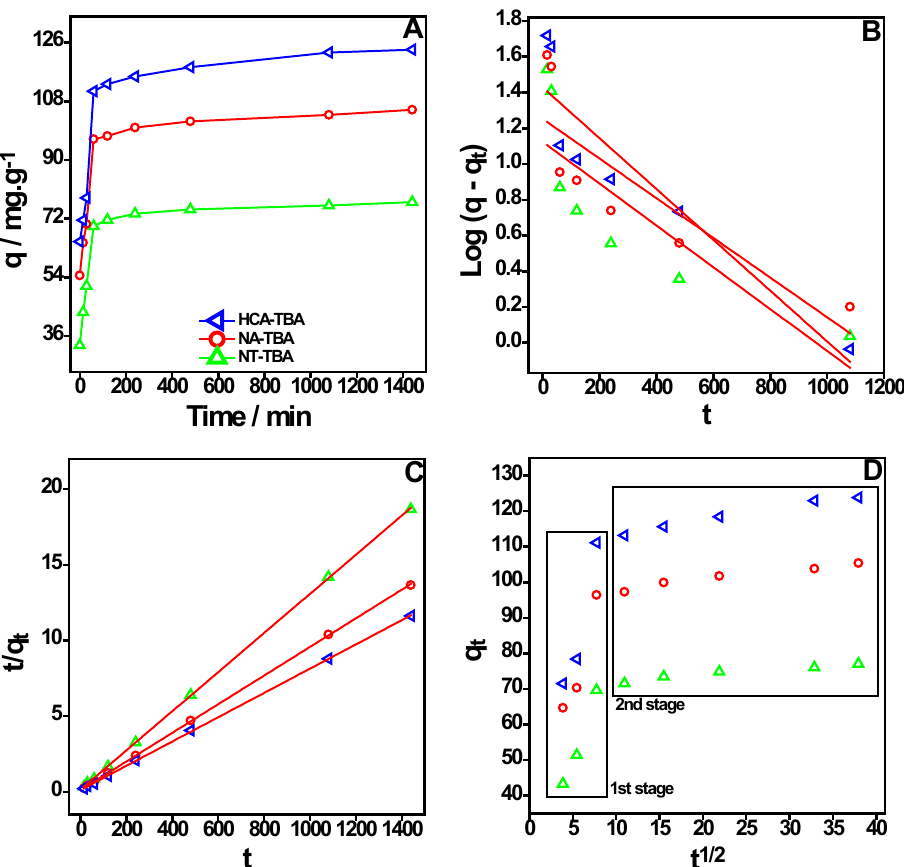
Figure 5: Effect contact time on Pb(II) uptake by original and chemically pretreated TBP (A), pseudo first order plot (B), pseudo second order plot (C) and intraparticle diffsuion plot (D) for Pb(II) biosorption by original and chemically pretreated